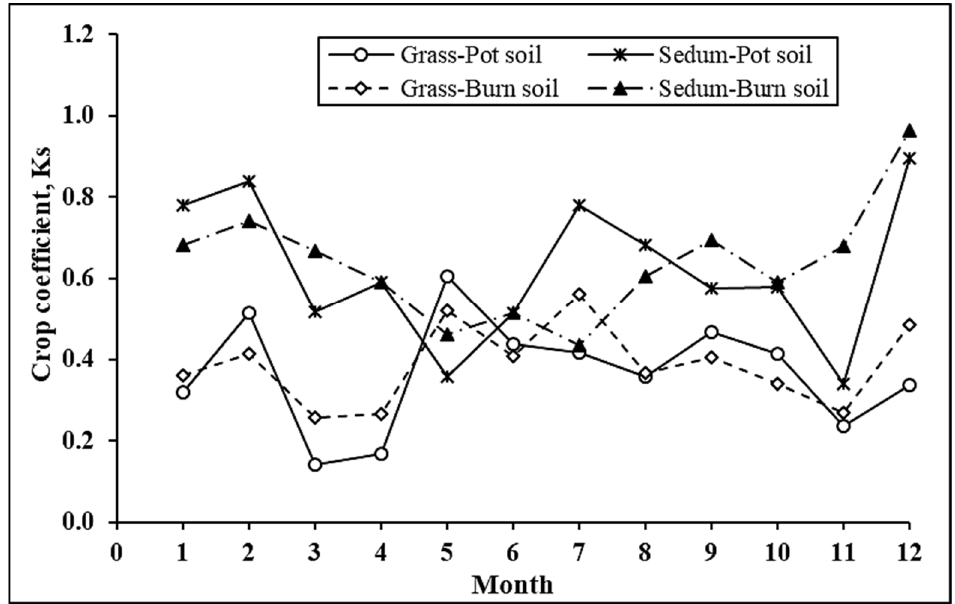
Figure 5. Variation of the crop coefficient (Ks) for different green roofs during the monitoring pe- riod.